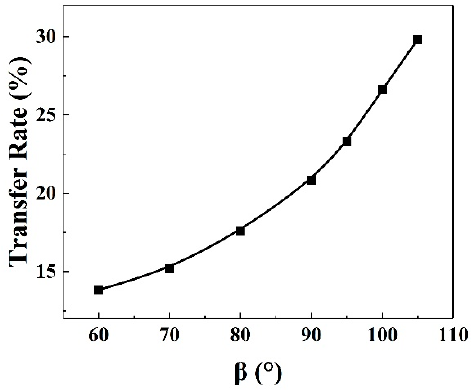
Figure 9. Change of liquid transfer rate with contact angle of cell.